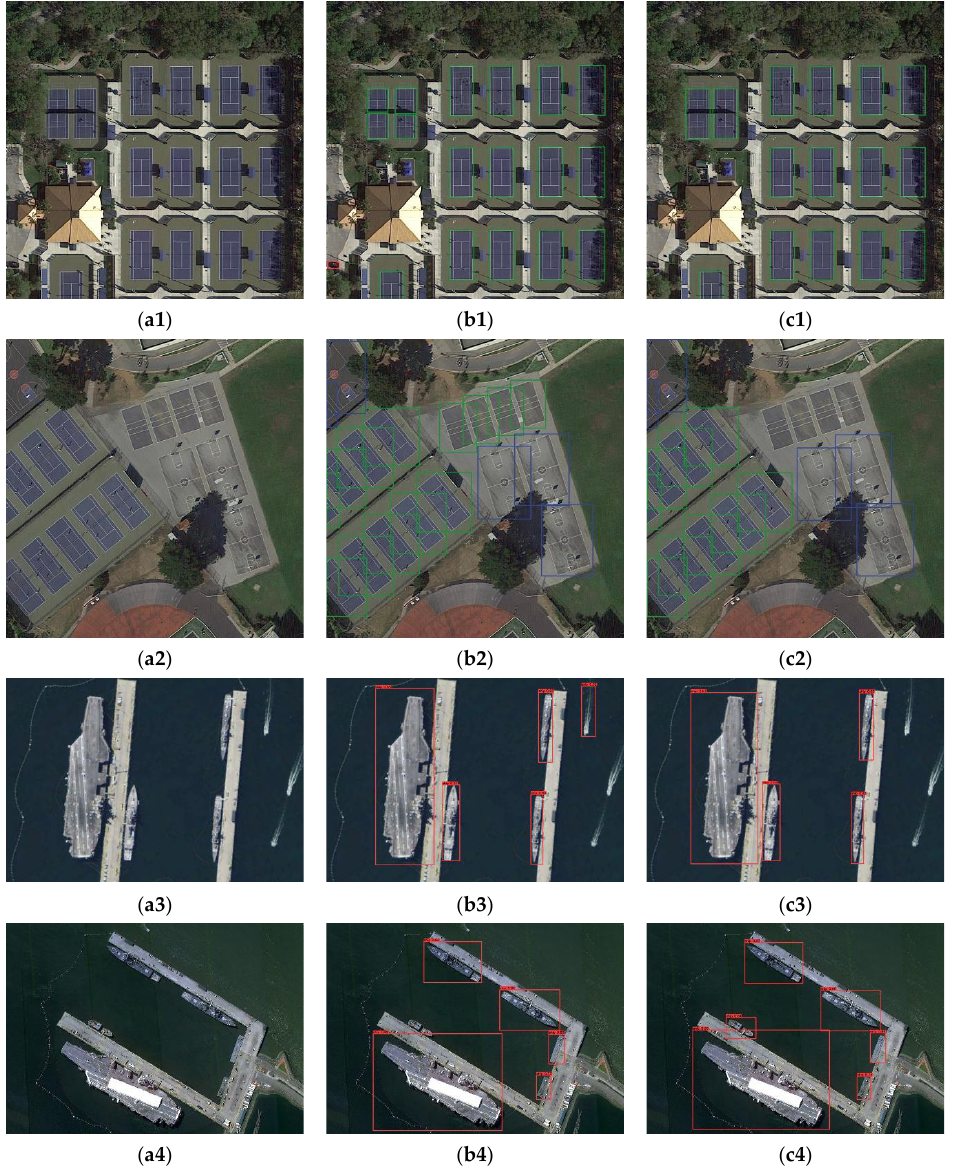
Figure 15. Comparison diagram on the DOTA dataset and the HRSC2016 dataset. ( a1 – a4 ) Represents the original image; ( b1 – b4 ) represents the experimental results of YOLOv5; ( c1 – c4 ) represents the experimental results of the network structure proposed by us.